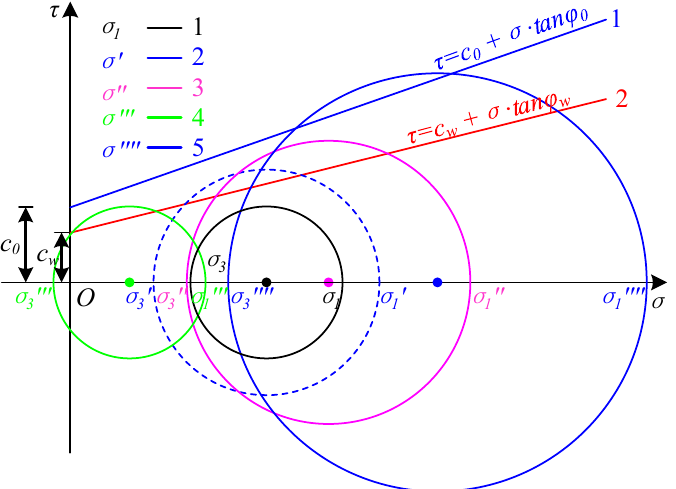
σ and σ are 1 3 and σ (cid:48) are 3 1